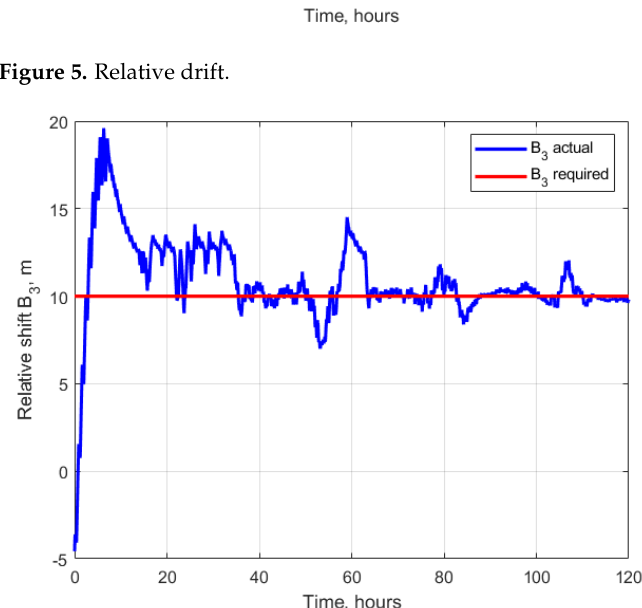
Figure 6. Relative shift. Figure 6. Relative